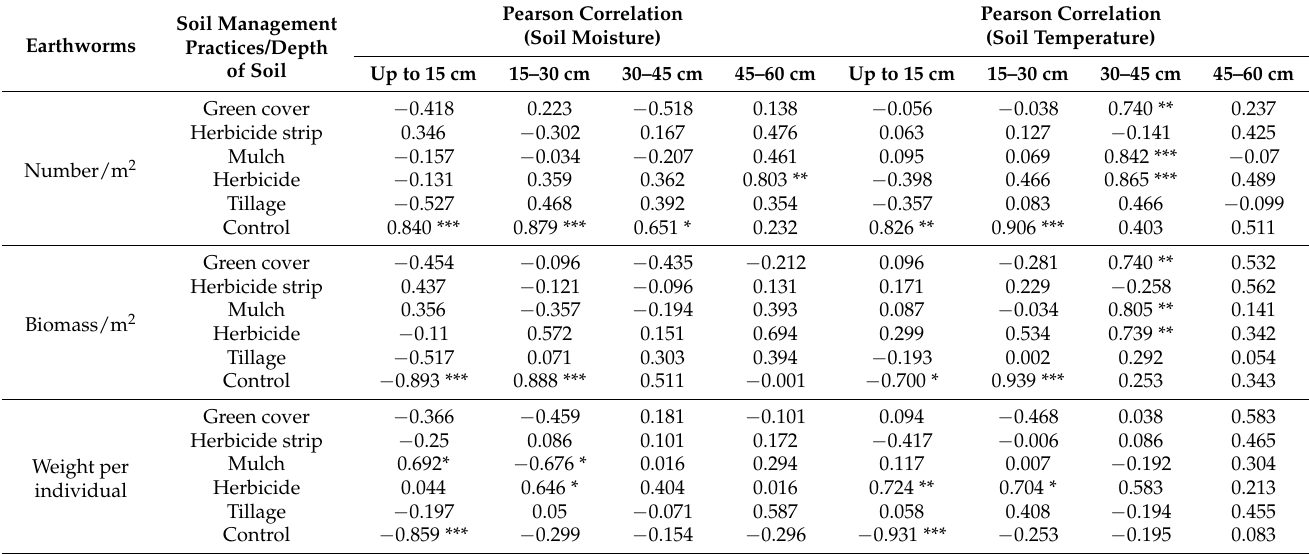
Figure 8. Relationship between mean soil moisture and the mean number and weight of earthworms along with the soil profile at depths from 0 to 60 cm; r—Pearson correlation index. Table 2. Correlations between earthworm parameters and soil moisture and temperature according to different soil management practices along with the soil profile at depths from 0 to 60 cm.